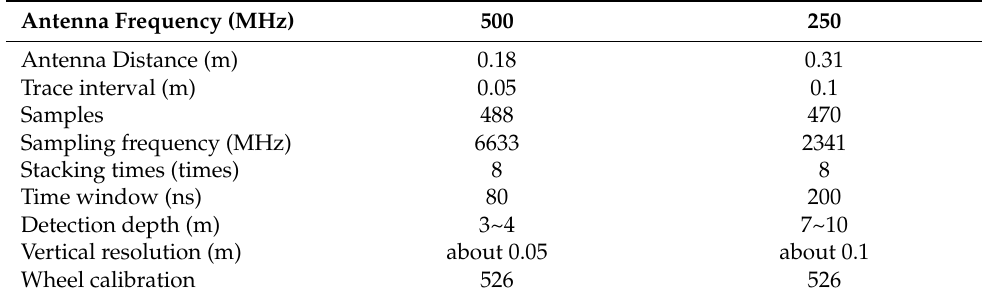
Figure 5. The integrated system of GPR and the differential GPS. ( a ) The GPS base station. The GPS base station is often placed on a tripod, where located in the study site with a high elevation. ( b ) The integrated system of GPR and DGPS. The GPS antenna of the mobile station is situated on the middle-position of the GPR antenna. When the GPR antenna is pulled on the surface, the GPR data and the geographical coordinates are simultaneously obtained with the help of the pulse signals of the survey wheel. Table 1. Data acquisition parameters of the different GPR